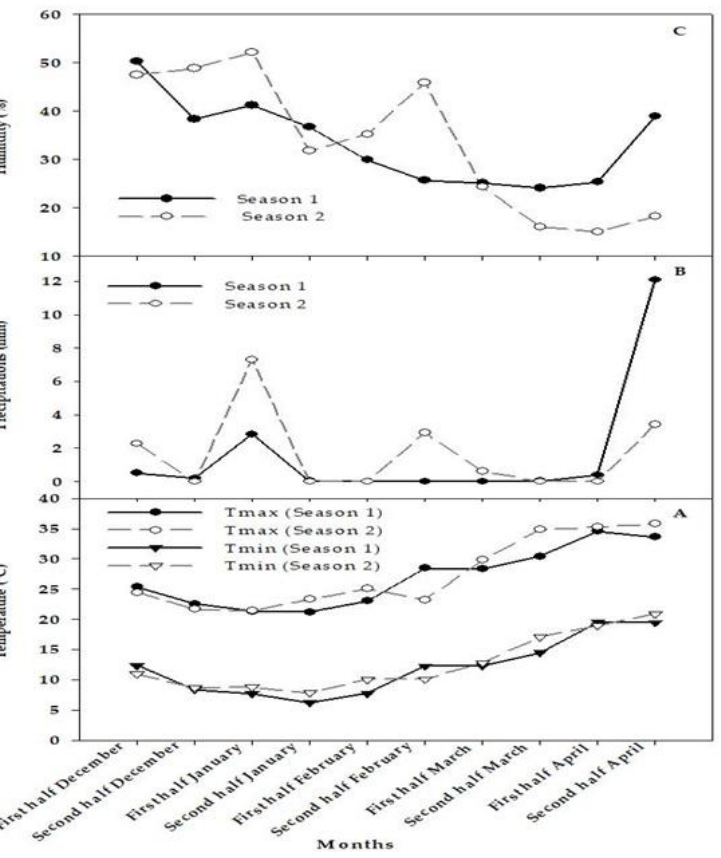
Figure 1. Average of maximum (Tmax) minimum (Tmin) temperature ( A ), precipitation ( B ), and humidity ( C ) during 2019–2020 (season 1) and 2020–2021 (season 2) of spring wheat-growing seasons at Dierab Experimental